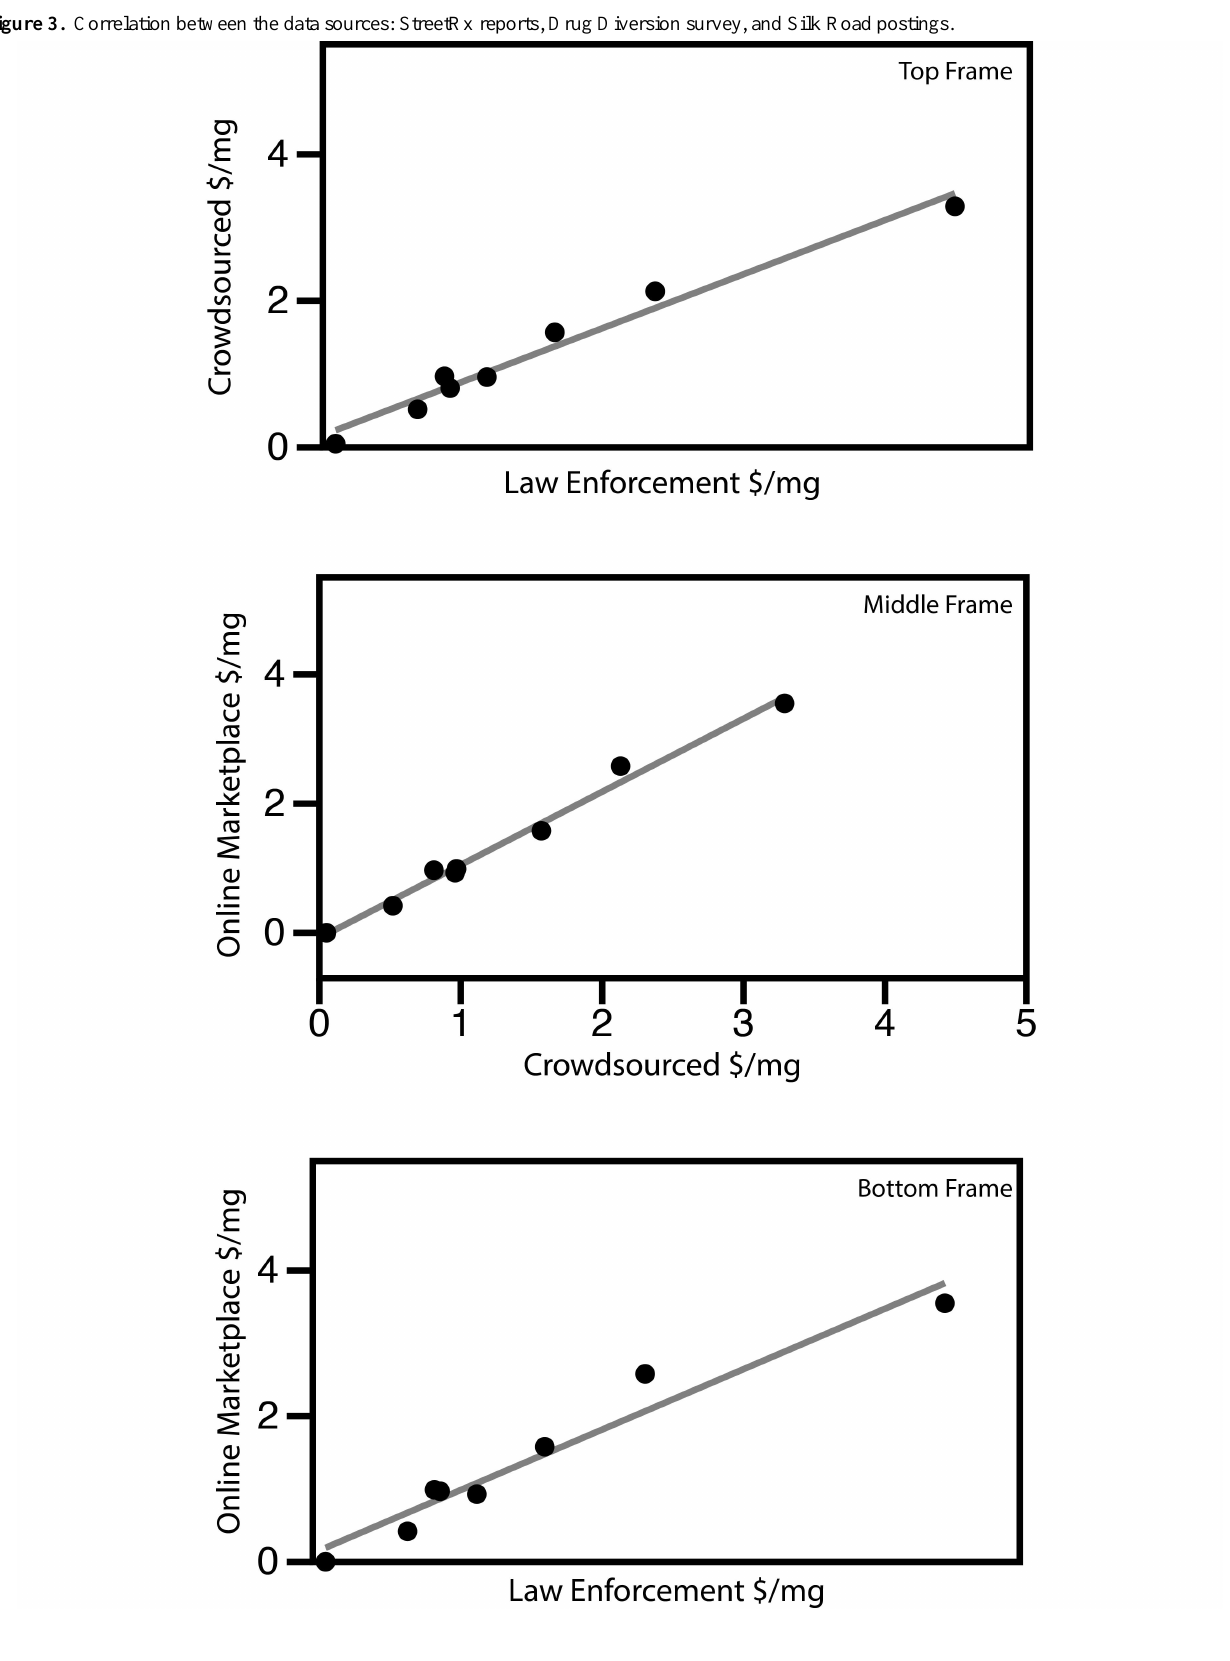
Figure 3. Correlation between the data sources: StreetRx reports, Drug Diversion survey, and Silk Road